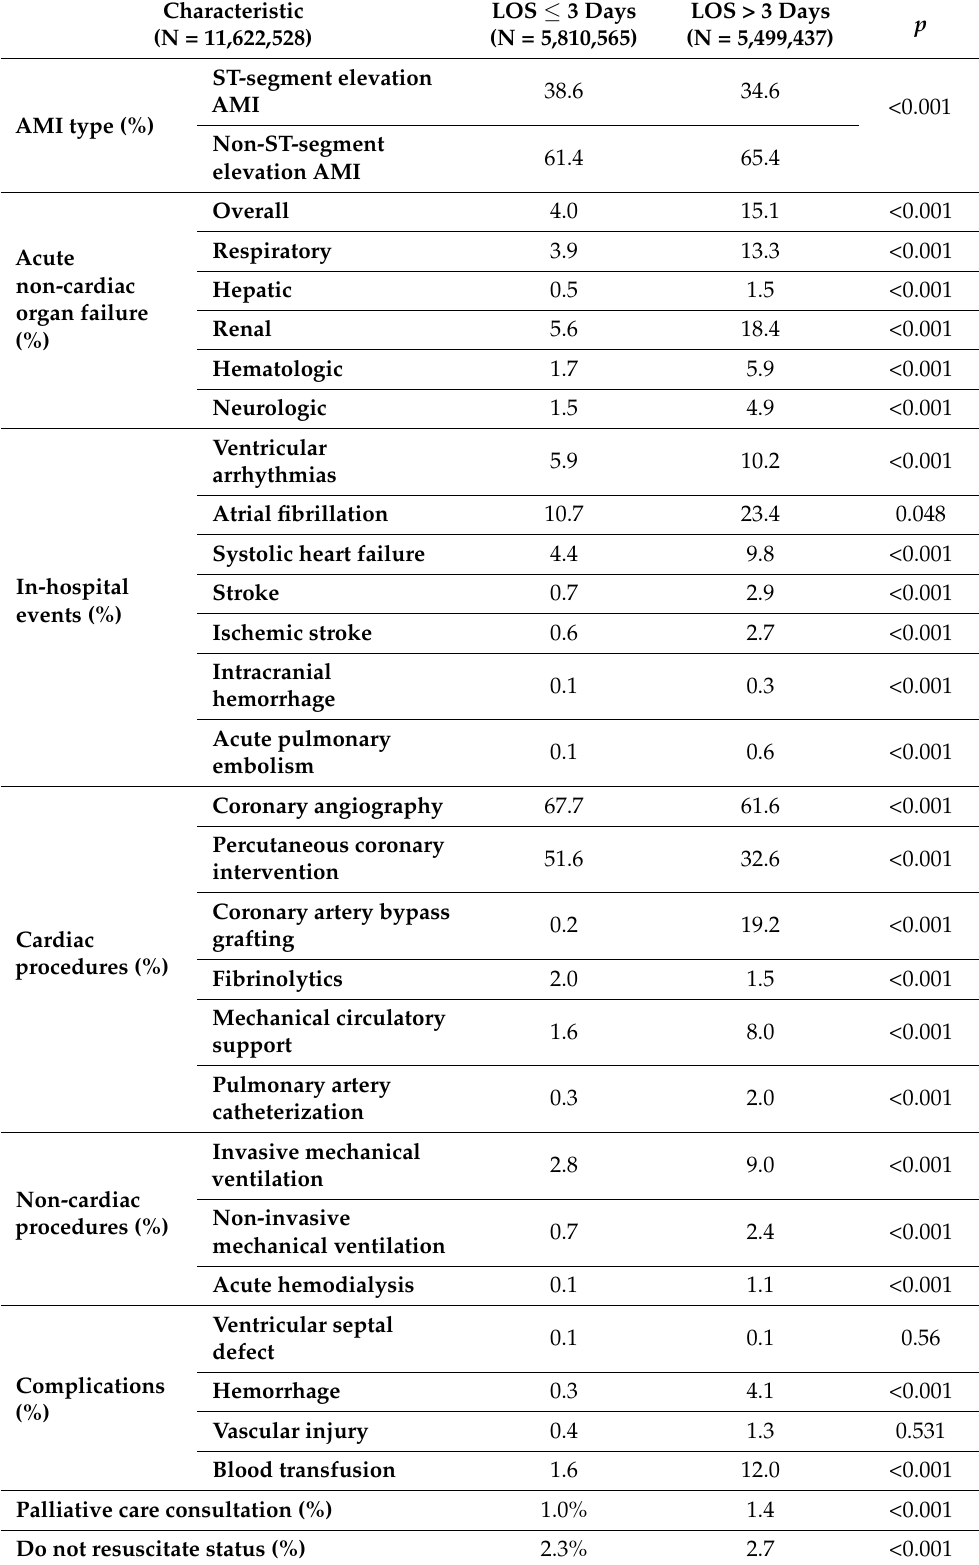
Table 2. In-hospital characteristics of AMI admissions LOS ≤ 3 days and LOS > 3